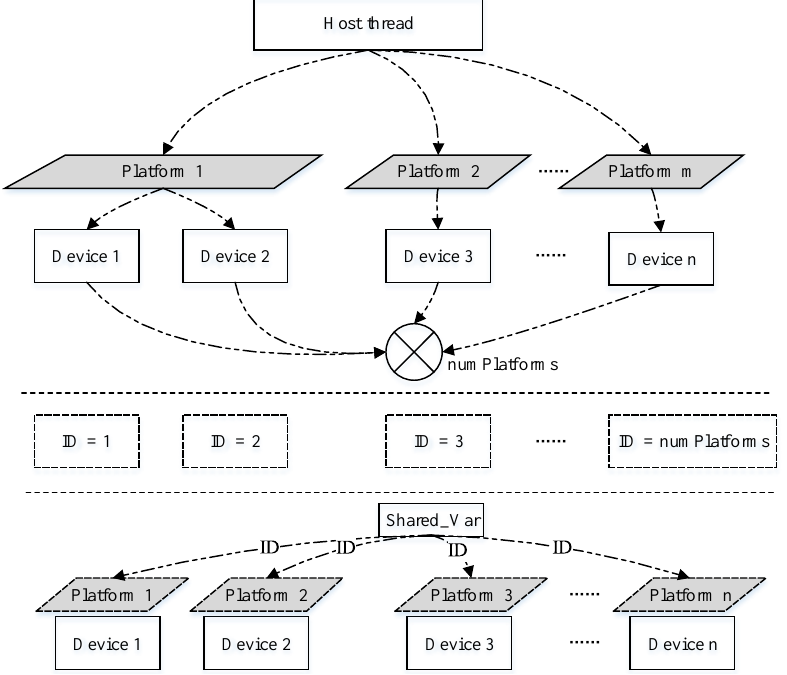
Figure 4. Implementation of the platform model.